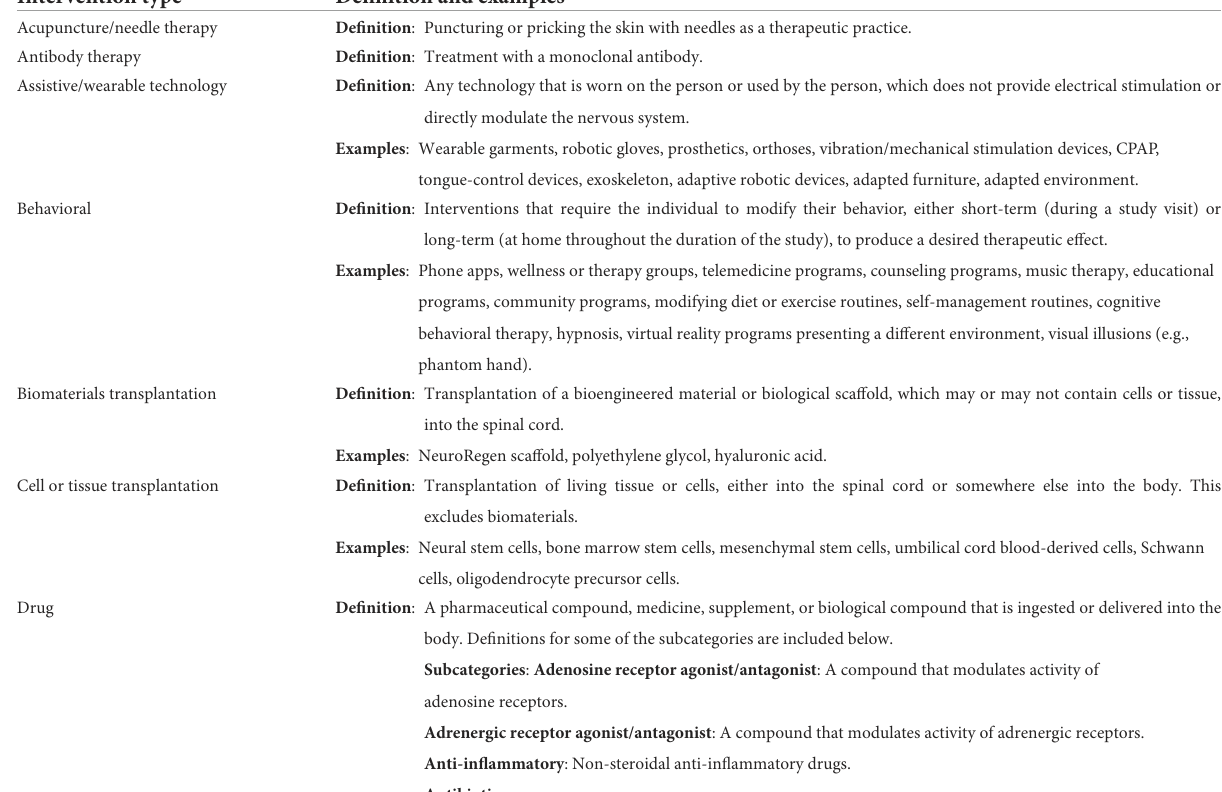
TABLE 1 Intervention